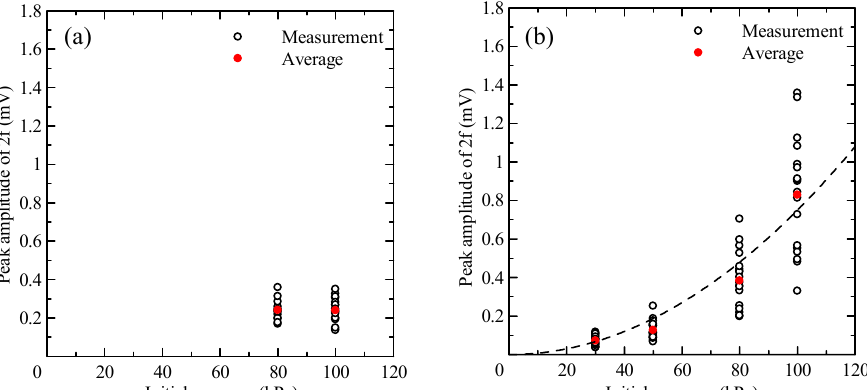
Fig. 7 The relation between peak amplitude of 2f and initial pressure: (a) Receiver 1, (b) Receiver 2.